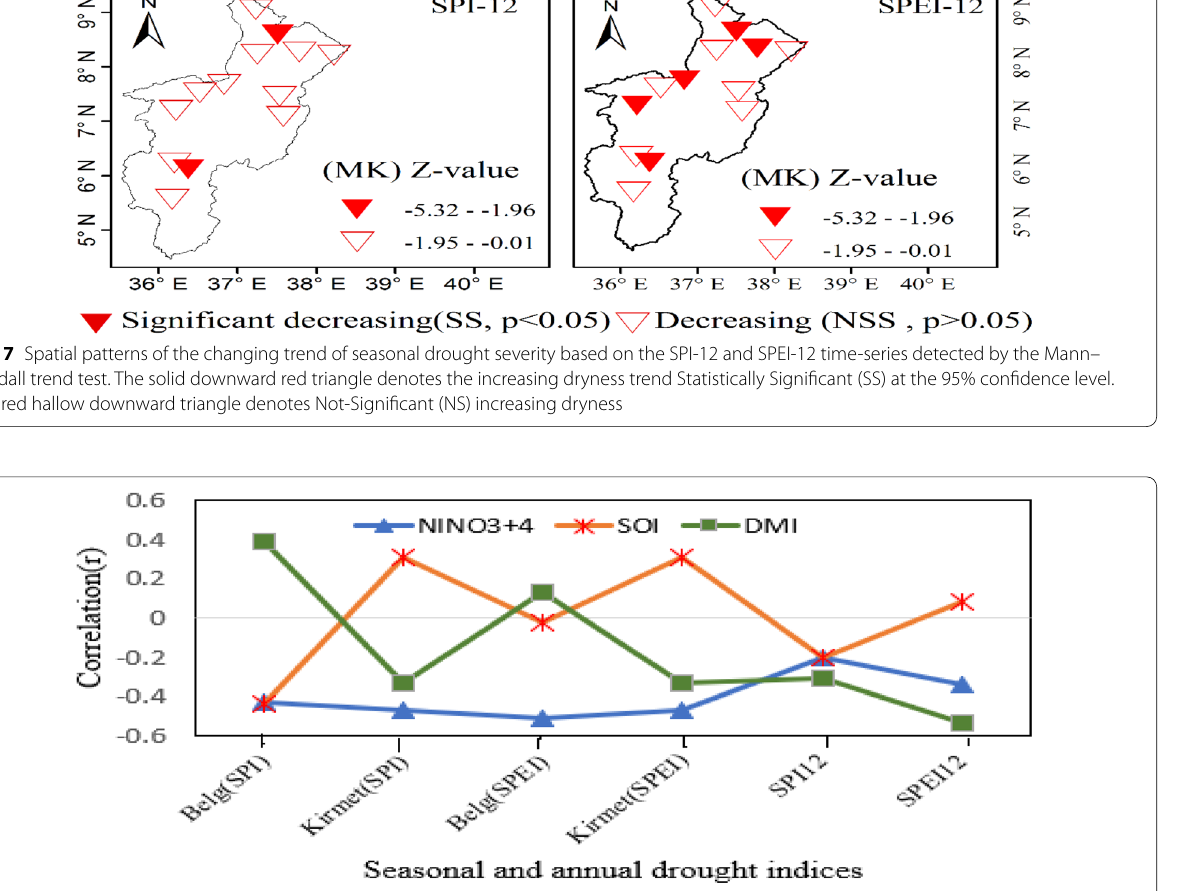
Fig. 8 Teleconnections of seasonal and annual drought indices (SPI/SPE) with global climate